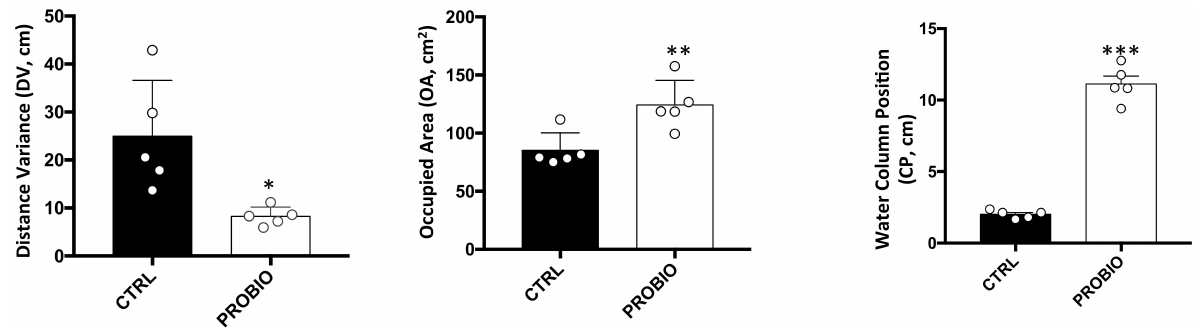
Figure 1. Behavioral parameters recorded in Zebrafish samples before and after probiotic treatment. Distance variance (DV), occupied area (OA) and water column position (CP) measurements in CTRL and RPOBIO groups. Statistical analysis has been performed using Student t -test (* p ≤ 0.05; ** p ≤ 0.01; *** p ≤